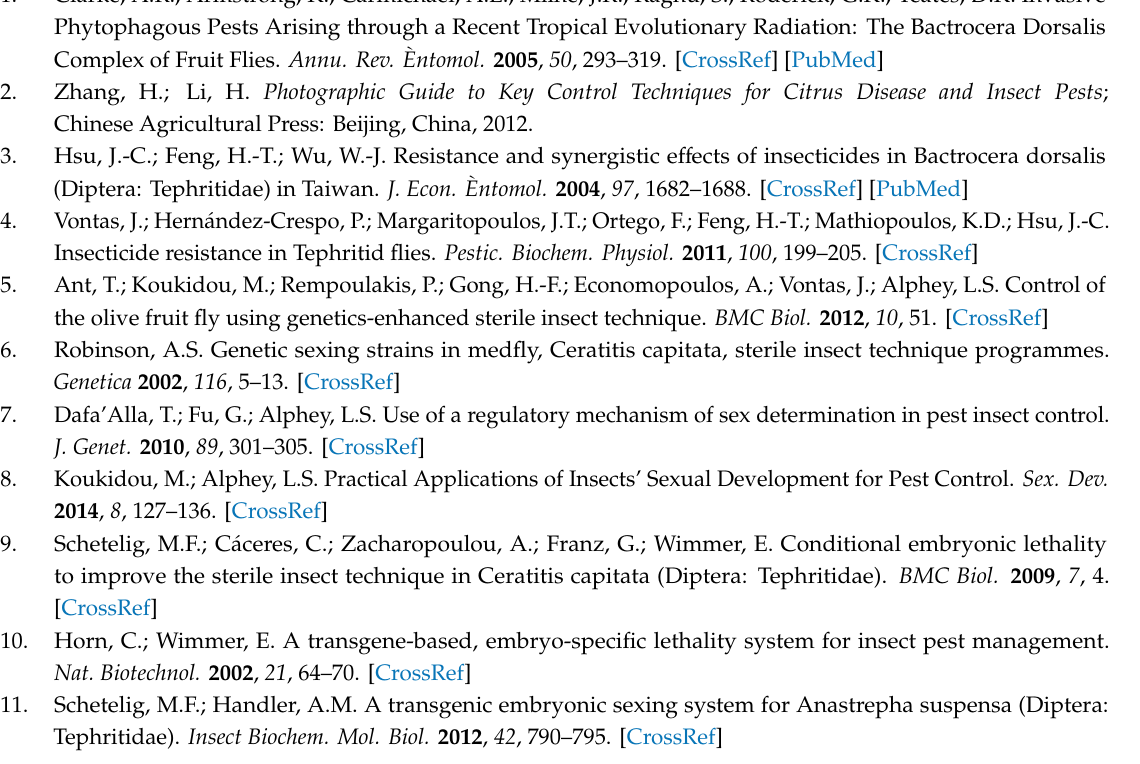
Figure S1: Distribution of unigene lengths in B. dorsalis early embryo transcriptomes. The sizes of all unigenes were calculated. Figure S2: Evaluation of sequence quality for the three early embryo developmental stages of B. dorsalis . Figure S3: Percent of reads mapped to the genome regions (exon, intergenic and intron) for the three early embryo developmental stages of B. dorsalis . Figure S4: The alternative splicing events during the early embryogenesis of B. dorsalis . SE, A5SS, A3SS, MXE and RI represent the skipped exon, alternative 5’ splice site, alternative 3’ splice site, mutually exclusive exons and retained intron (RI) respectively. Table S1: Primers used in our study. Table S2: All genes description and FPKM value during the embryogenesis in B. dorsalis . Table S3: Di ff erentially expressed genes in each pairwise comparison during the embryogenesis in B. dorsalis . Table S4: GO classification of the di ff erentially expressed genes in each pairwise comparison during the embryogenesis in B. dorsalis . Table S5: KEGG pathway enrichment analysis for di ff erentially expressed genes in each pairwise comparison during the embryogenesis in B. dorsalis